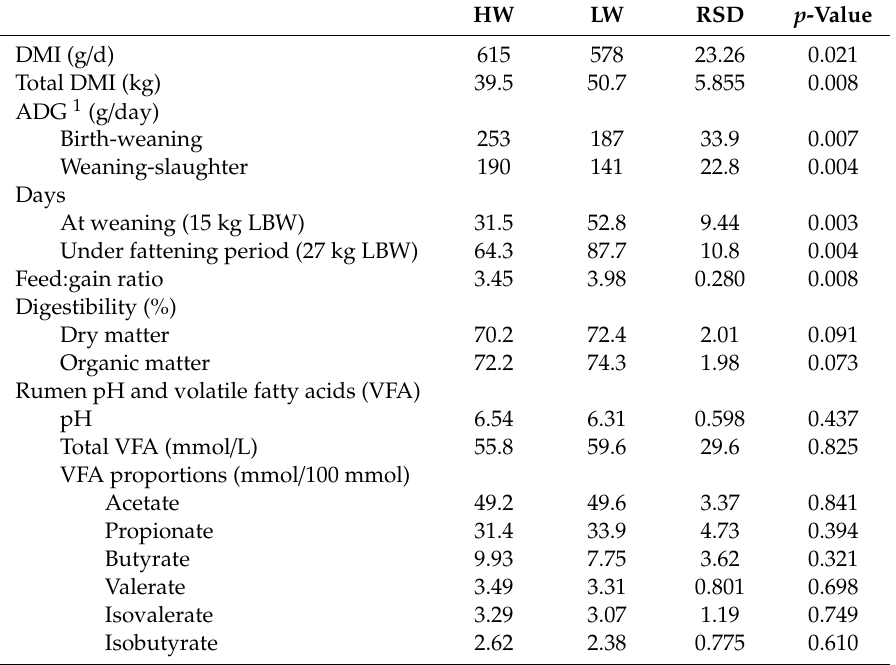
Table 1. Feed intake, growth performance, digestibility and ruminal fermentation parameters in lambs born with high (HW) or low weight (LW) during the fattening period.